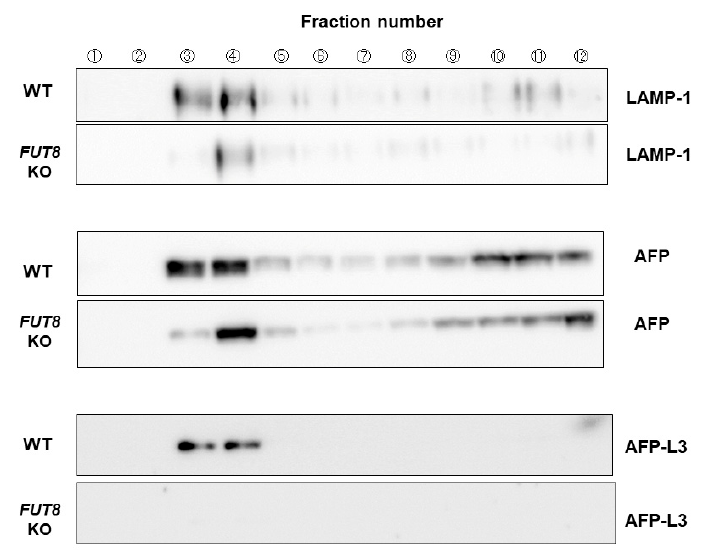
Figure 3. Immunoblots of endosome fractions obtained by ultracentrifugation. FUT8 KO and WT HepG2 cells were subjected to cellular fractionation by ultracentrifugation. The results of immunoblots using anti-LAMP-1, anti-AFP, and anti-AFP-L3 antibodies after electrophoresis are shown. Fractions 3 and 4 were identified as endosome fractions as they colocalized with the endosome marker LAMP-1, and they were used for subsequent immunoprecipitation